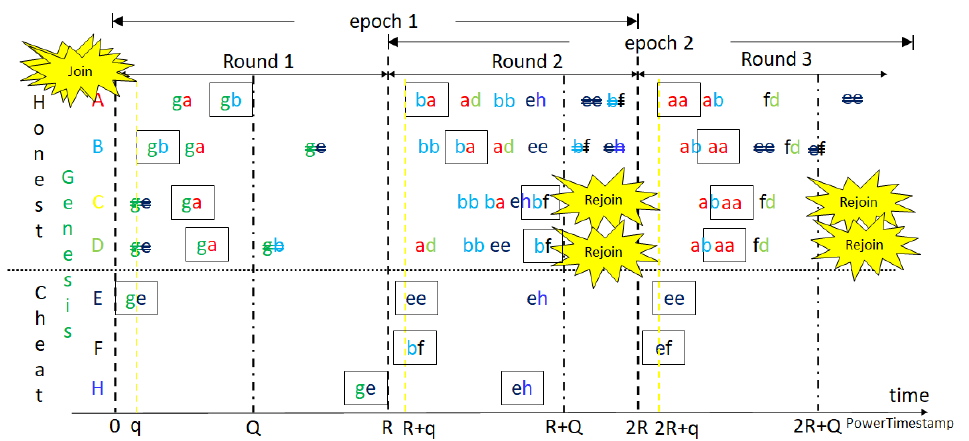
Figure 10. GPoW mining with 2-block